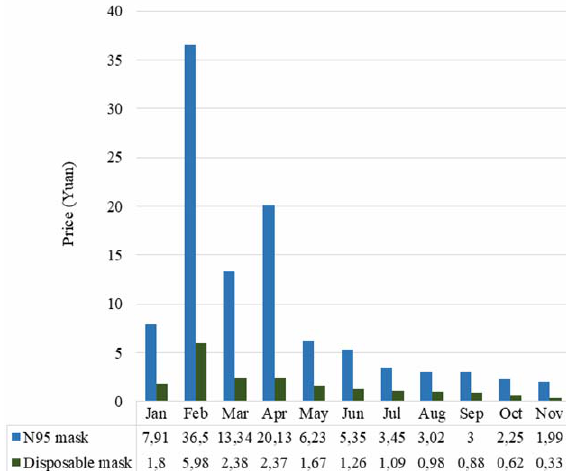
Figure 2: Changes in the price of face masks in 2020, adapted from [16].